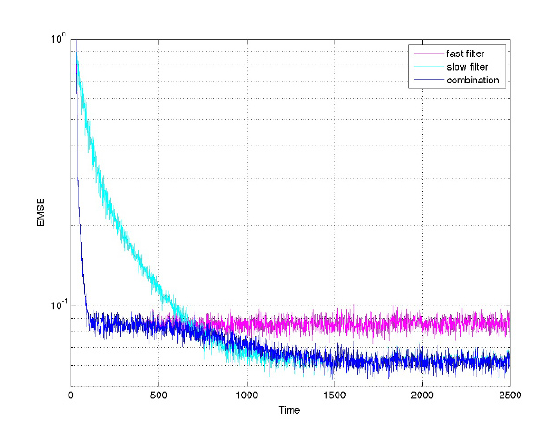
expressed in terms of the enhancer parameters, the sec- ond order statistics of the input process and the optimum Wiener filter weights. The Capon method was then used Figure 7. Evolution of EMSE of the two component filters and the combination in time. to compute power spectra from the correlation matrices. In the simulation study we demonstrated a good resemblance between the theoretical and simulation The evolution of the excess mean square error of the combination together with that of the individual filters is shown in Figure 7. The curve is again averaged over 100 independent trials. We see the fast initial convergence, which is due to the fast adapting filter. After the initial convergence there is a period of stabilization followed by a second convergence between the sample times 500 and 1500, when the error power of the slowly adapting filter bypasses that of the fast one.